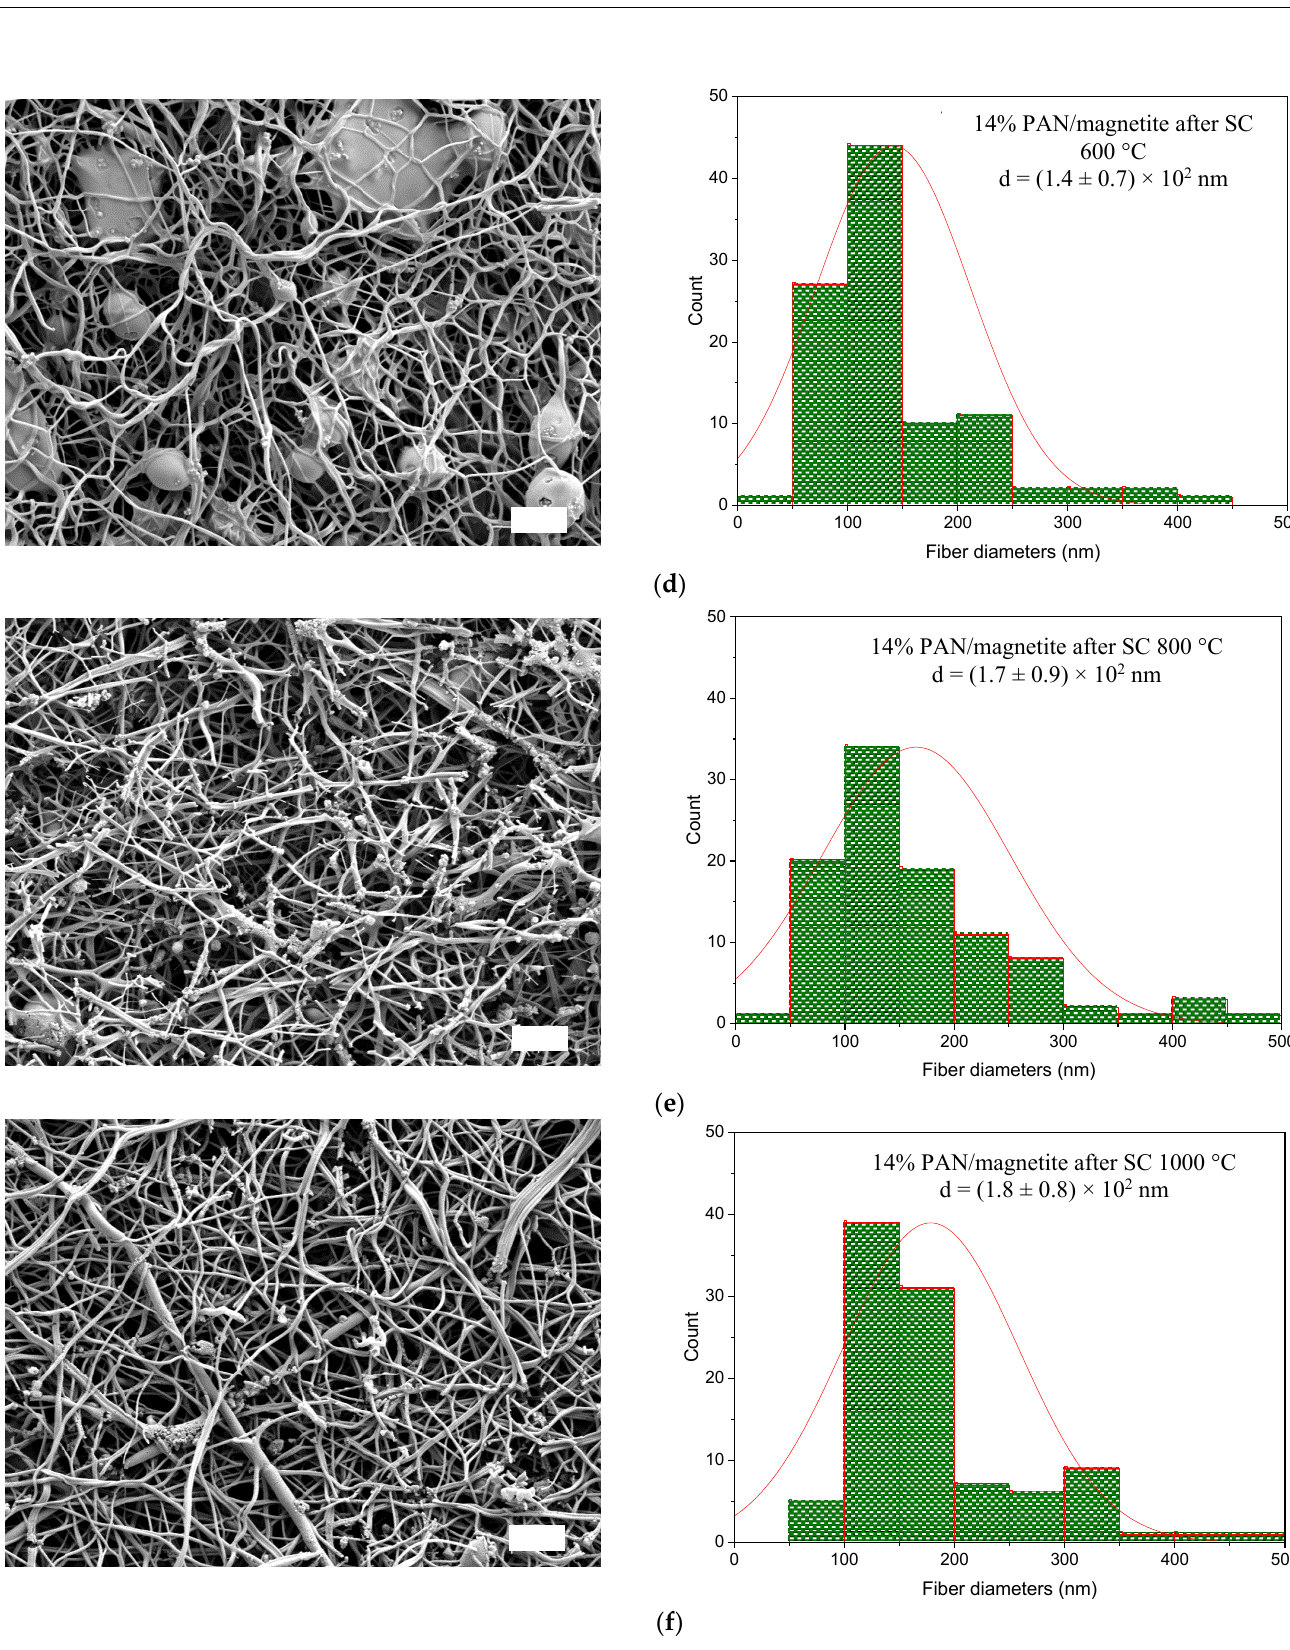
Figure 5. Scanning Electron Microscope ( SEM) micrographs and distributions of the fiber diameters of ( a ) PAN/magnetite nanofiber mat after electrospinning, ( b ) stabilized at 280 °C, ( c ) carbonized at 500 °C, ( d ) carbonized at 600 °C, ( e ) carbonized at 800 °C, and ( f ) carbonized at 1000 °C. The scale bars indicate 2 μ m.